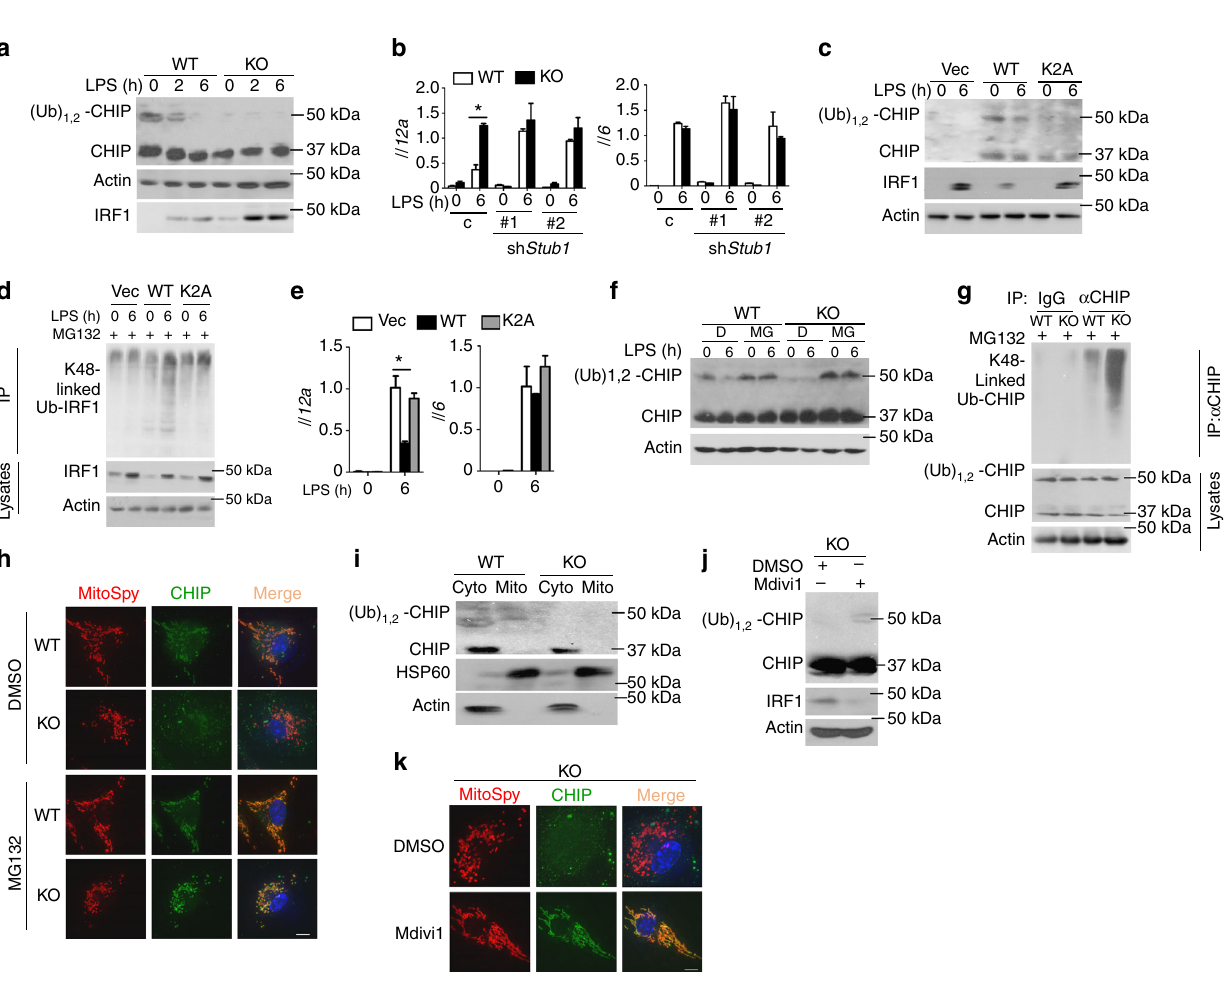
Fig. 6 CHIP monoubiquitination is involved in IRF1 degradation. a IB analysis of CHIP and monoubiquitinated CHIP in the cytoplasm and IRF1 in the nucleus after stimulation with LPS as indicated. b WT or FAM73b KO BMDMs were infected with shRNA (C) or two different Stub1 -speci fi c shRNAs. qRT-PCR analysis of the indicated cytokines. c , d CHIP-de fi cient RAW264.7 cells were reconstituted with WT and mutant CHIP. c IB analyses of the indicated proteins in subcellular fractions. d IRF1 polyubiquitination in whole-cell lysates. e qRT-PCR analysis of Il12a and Il6 mRNA in reconstituted RAW264.7 cells. f , g WT and FAM73b KO BMDMs were treated with MG132 for 30 min before being collected. IB analyses of CHIP monoubiquitination in the cytoplasm ( f ) and the polyubiquitination level ( g ). h Confocal microscopy analyses of CHIP location. i Immunoblot analysis of CHIP in mitochondrial or non-mitochondrial extracts. The purity of the mitochondrial fraction was con fi rmed using antibodies targeting HSP60 (a mitochondria marker) and Actin. j , k FAM73b KO BMDMs were treated with Mdivi-1 for 12 h. The protein level and location of CHIP were measured by IB ( j ) and confocal microscopy ( k ). The data are representative of three independent experiments. Scale bars in h and k are 10 μ m. Statistical analyses represent variations in experimental replicates. Two- tailed unpaired t -tests were performed; * P <